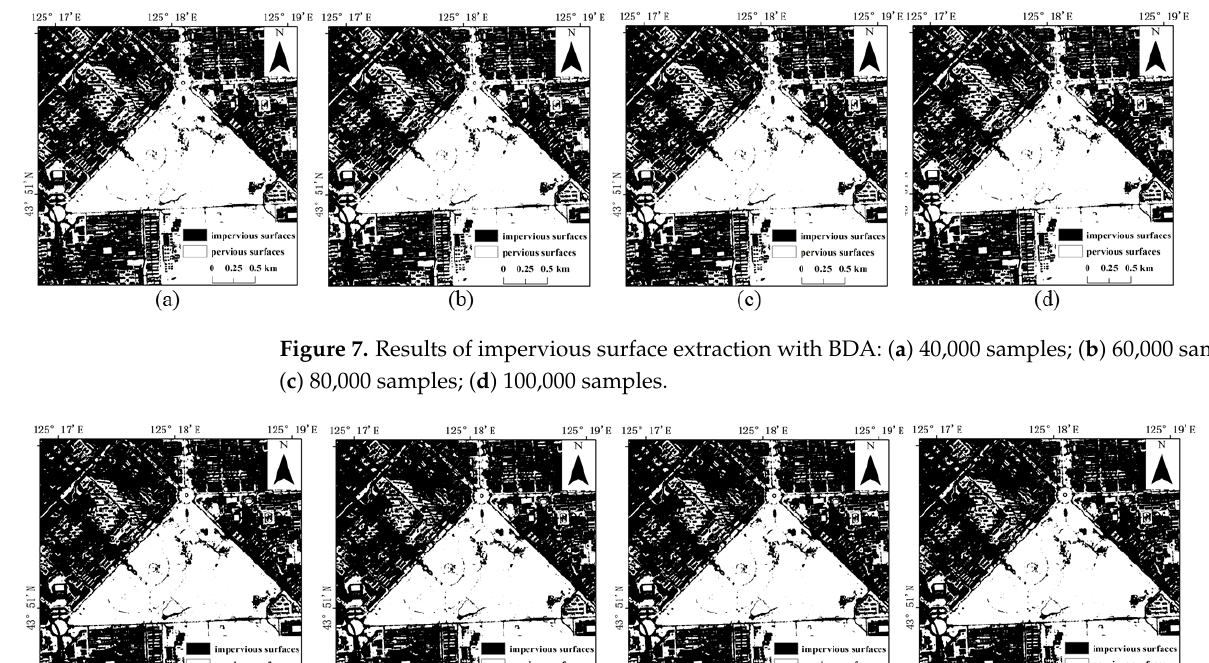
Figure 6. Results of impervious surface extraction with RF: ( a ) 40,000 samples; ( b ) 60,000 samples; ( c ) 80,000 samples; ( d ) 100,000 samples.